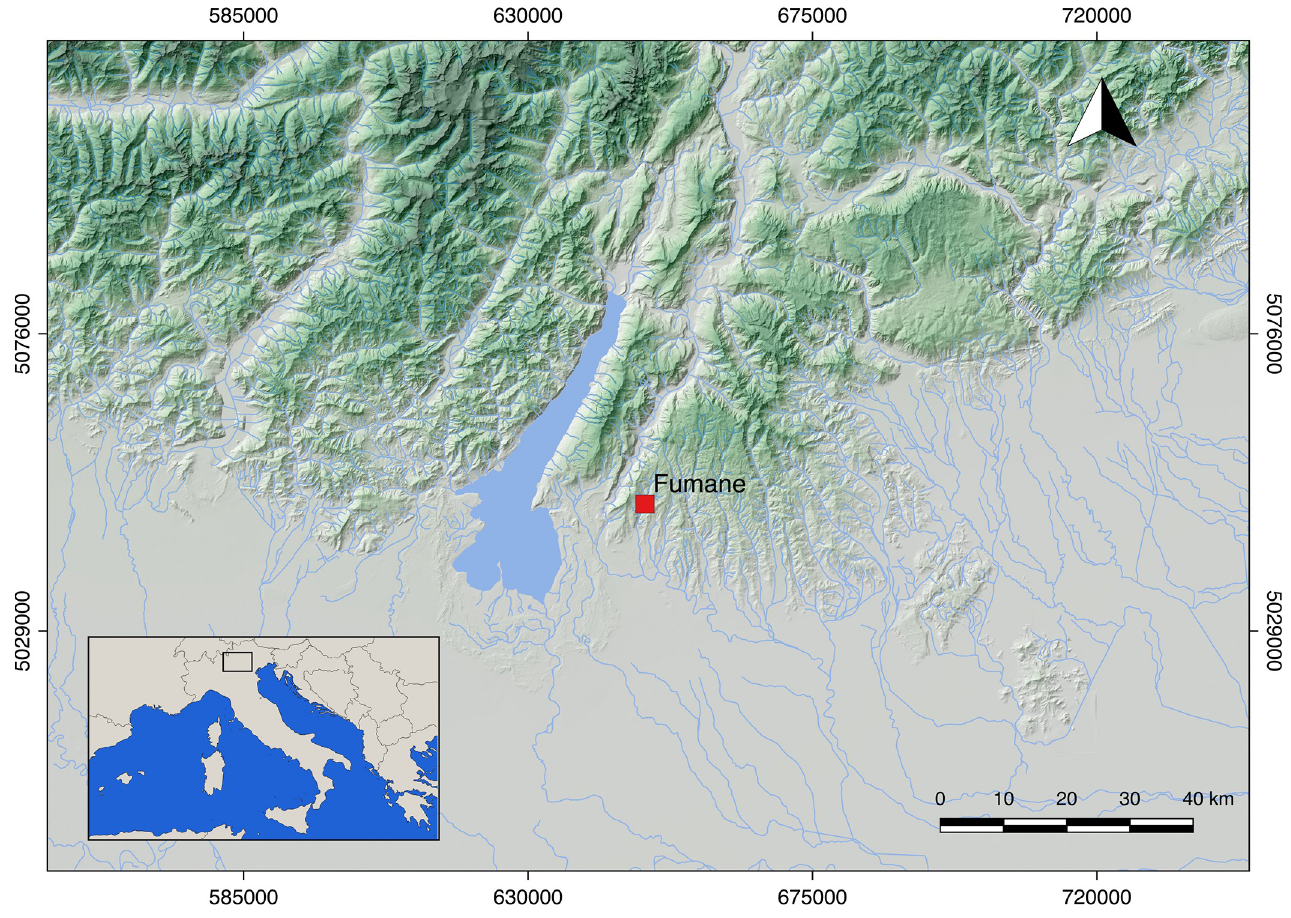
Fig 1. Map showing the localization of Fumane Cave (Verona, Italy).